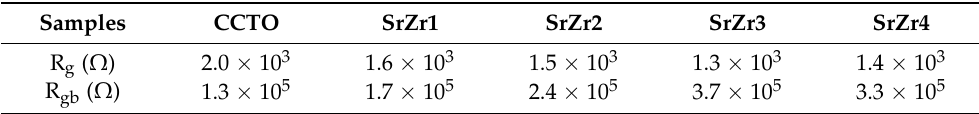
Table 3. Values of R g and R gb respectively associated with grains and grain boundaries obtained for the CCTO, SrZr1, SrZr2, SrZr3, and SrZr4 ceramics. Samples